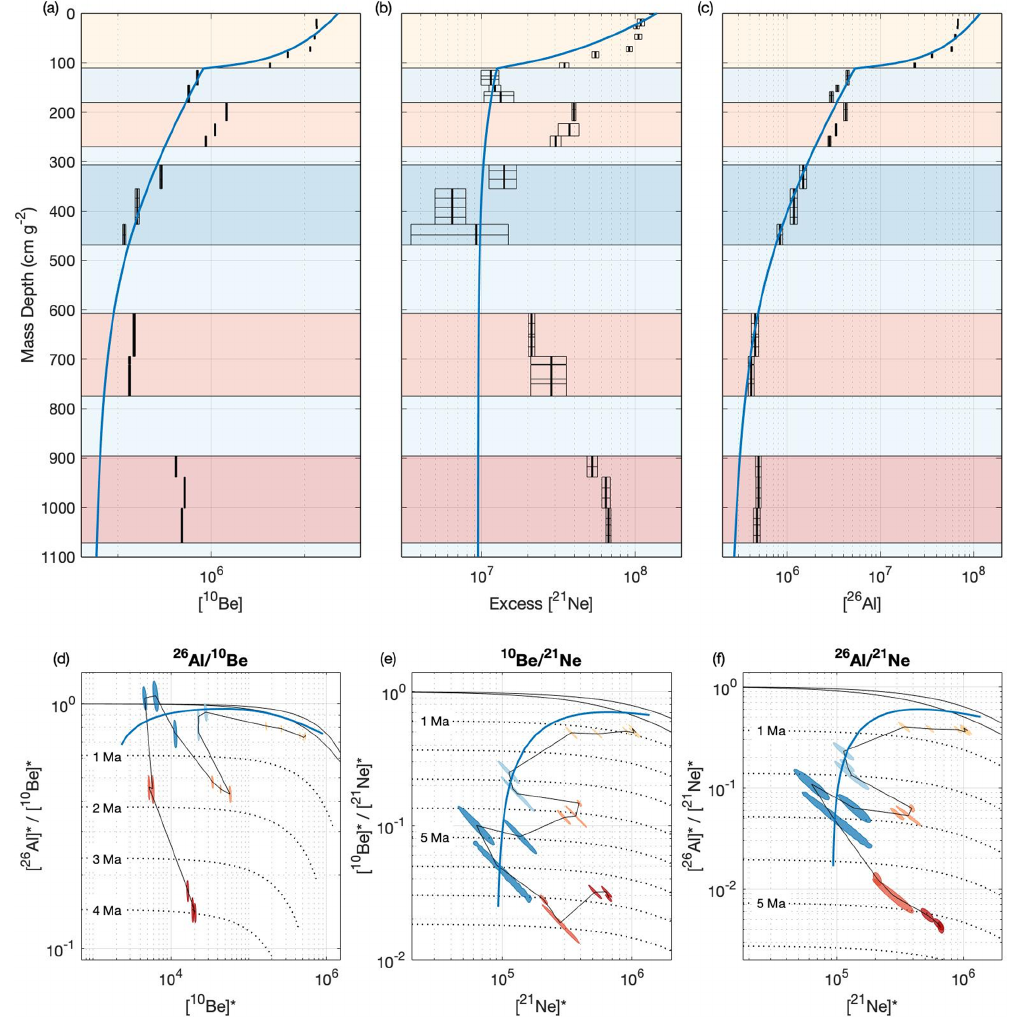
Figure 9. Measured and modeled cosmogenic nuclide concentrations as (a–c) mass depth below the surface for (a) 10 Be, (b) 21 Ne, and (c) 26 Al and (d–f) paired-nuclide exposure–burial diagram for (d) 26 Al– 10 Be, (e) 10 Be– 21 Ne, and (f) 26 Al– 21 Ne pairs. Blue lines indicate the model predicted cosmogenic nuclide concentration from the pit surface to the bottom of the ice core. Colored boxes (a–c) and sample colors (d–f) indicate debris source as detailed in Fig. 7. In (d) – (f) , solid black lines show the steady-state erosion zone, and dashed lines show the burial lines as million-year decay isochrons (see Sect. 3 for more details). The measured nuclide concentration for each sample is represented by a shaded ellipse of its 1 σ uncertainty. The black line connects the sample ellipses from the surface of the pit down to the bottom of the ice core. ∗ signifies nuclide concentrations normalized to respective surface production